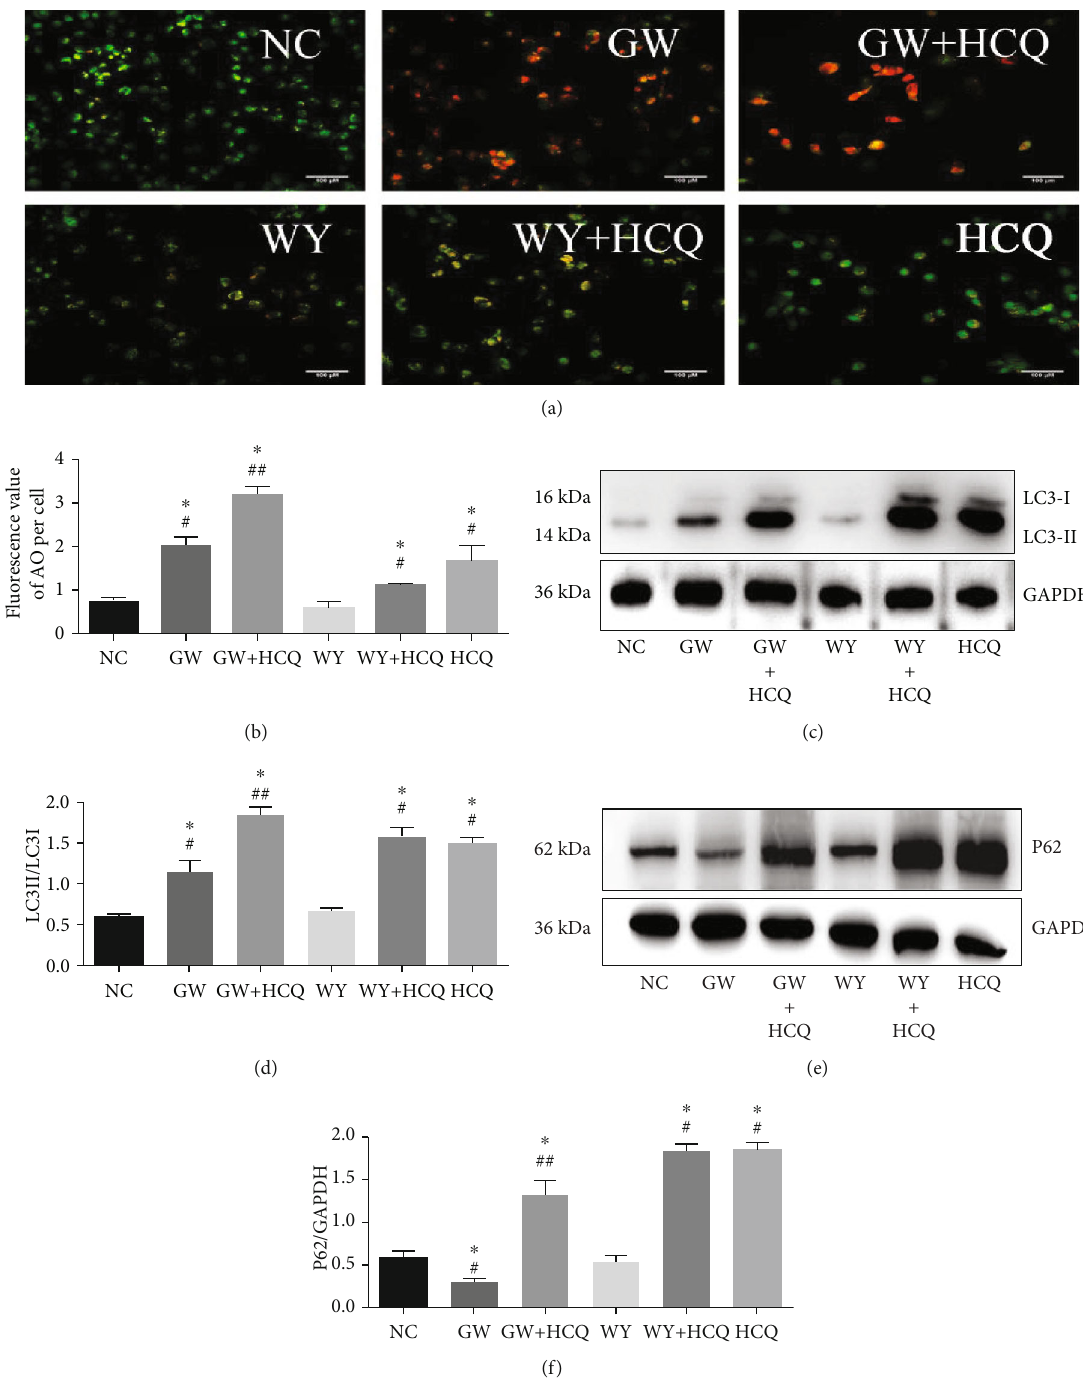
Figure 3: GW6471-induced integral autophagy in 786-O cells. (a) Images of AO dyed in 786-O cells treated with di ff erent groups of drugs. (b) Semivalue of AO ’ s fl uorescent signal in 786-O cells treated with di ff erent groups of drugs normalized to per cell. (c) The expression of LC3-I/II was analyzed by western blotting. (d) Ratio of LC3-II/LC3-I. (e) Expression of p62 was analyzed by western blotting. (f) Semiquanti fi cation of p62 normalized by GAPDH. (25 μ M GW6471, WY14643, and 50 μ M hydroxychloroquine was applied in validating autophagic fl ux and the remaining experiment. ( n = 3 , one-way ANOVA with LSD ∗ P < 0 : 05 , # compared with untreated group (NC), ## compared with the group of